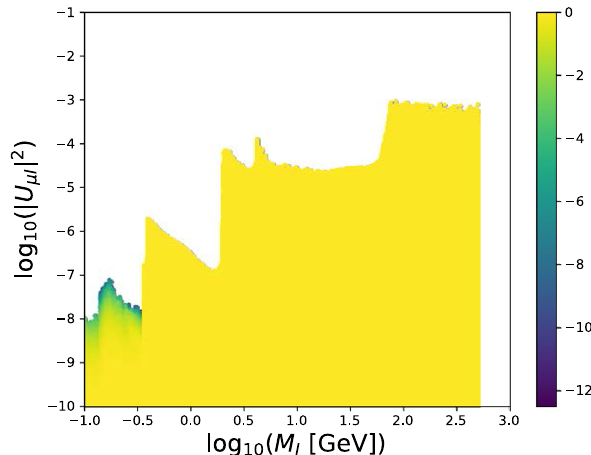
Fig. 23 Partial likelihood from direct searches with CMS, e -channel, in the M I − | U eI | 2 plane